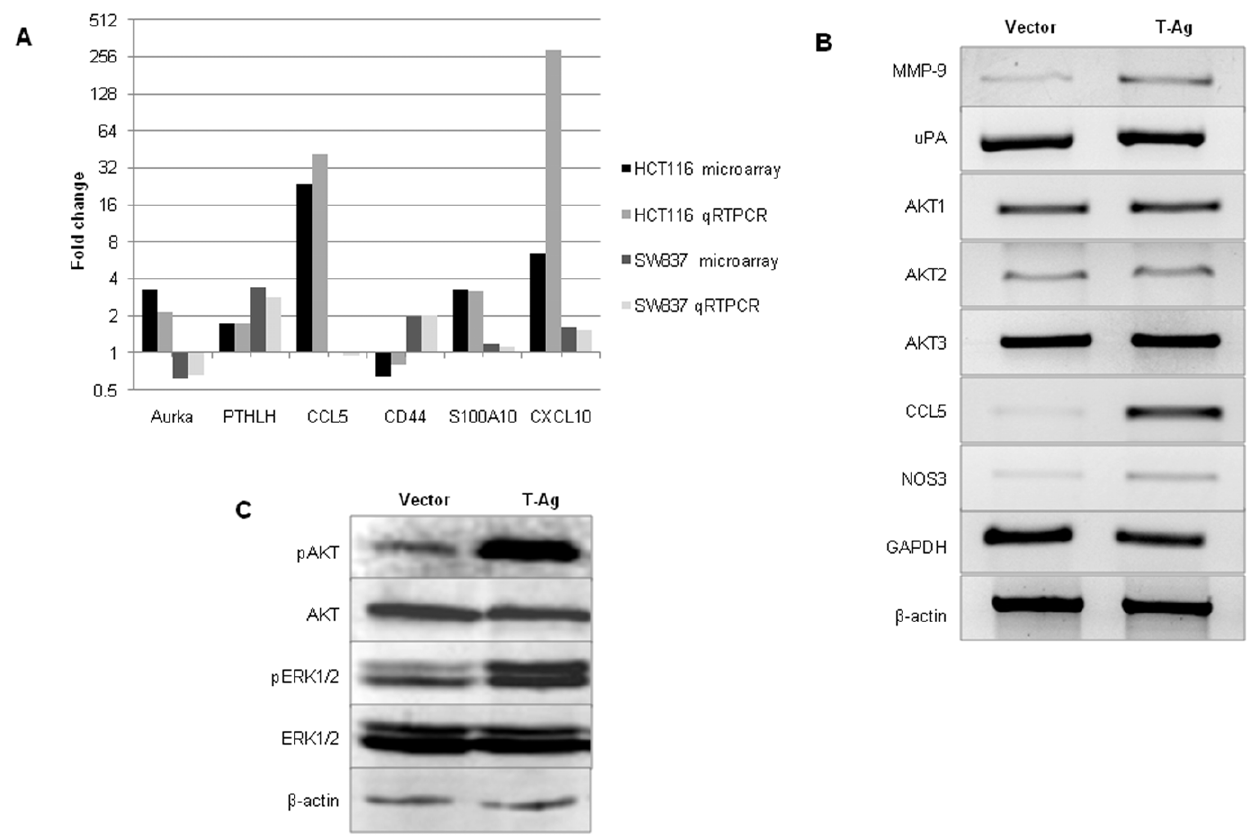
Figure 4. Gene expression changes following T-Ag transfection in HCT116 cells. (A) Microarray global gene expression data were validated in a randomly selected subset of genes by quantitative RT-PCR. Data are represented as the mean fold change normalized to vector cells. As indicated, there was a tight correlation between microarray and qRT-PCR in each instance. (B) A subset of cancer-metastasis related genes including MMP-9, uPA, CCL5 and NOS3 showed increased expression following T-Ag transfection in HCT116 cells. (C) Western blotting data indicated increased phosphorylation of AKT as well as ERK1/2 in T-Ag transfected cells in comparison to control cell lines. doi:10.1371/journal.pone.0008146.g004 ( Figure 6B ) as well as liver cells ( Figure 6C ) showed no T-Ag staining in comparison to the positive control tissue ( Figure 6A ).